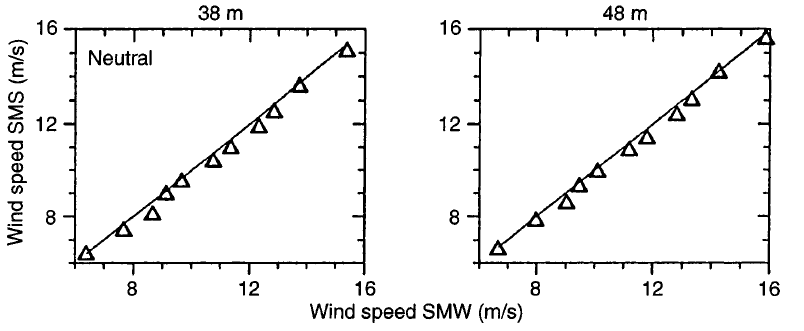
Fig. 4. Empirical quantile-quantile plots from wind speeds (m/s) at SMS and SMW at 38 and 48 m under near-neutral conditions with flow from the south sector